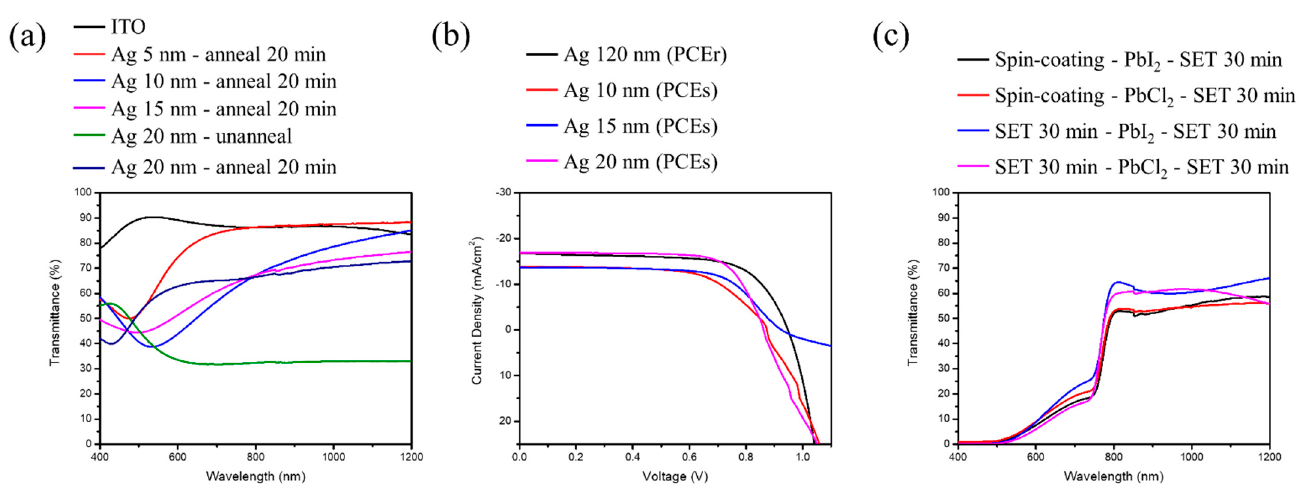
Figure 7. ( a ) UV-vis transmission spectrum of different thickness of Ag grown on ITO substrates. ( b ) J–V characteristic of perovskite solar cells for different thickness of Ag as transparent electrodes. ( c ) UV-vis transmission spectrum of ST-PSC for different sandwich structures. Table 4. Characteristic of PSCs using different thickness of Ag transparent electrodes.